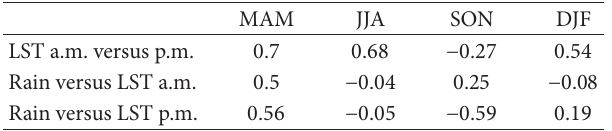
Table1:CorrelationcoefficientbetweenEOFpatterns(fortheAma- zon